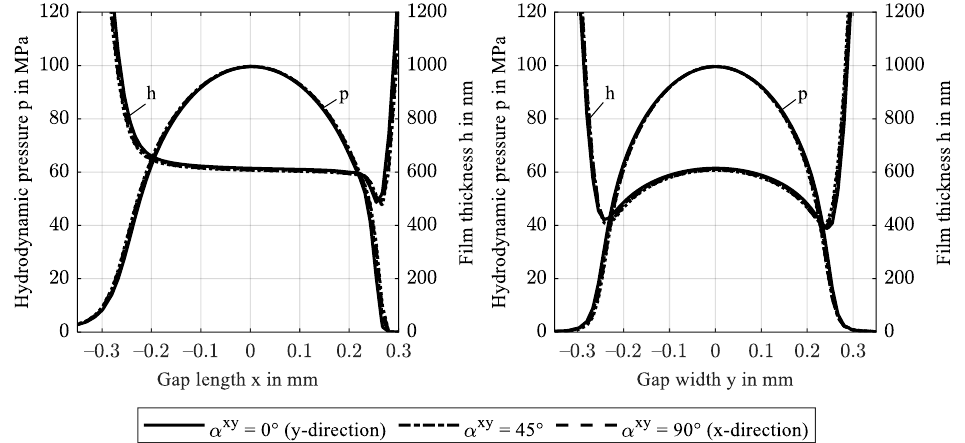
Figure 10. Hydrodynamic pressure p and film thickness profiles h along the gap length x at y = 0 (left) and along the gap width y at x = 0 (right) for a rotation 𝛼 𝑥𝑦 of fiber orientation in the xy-plane.